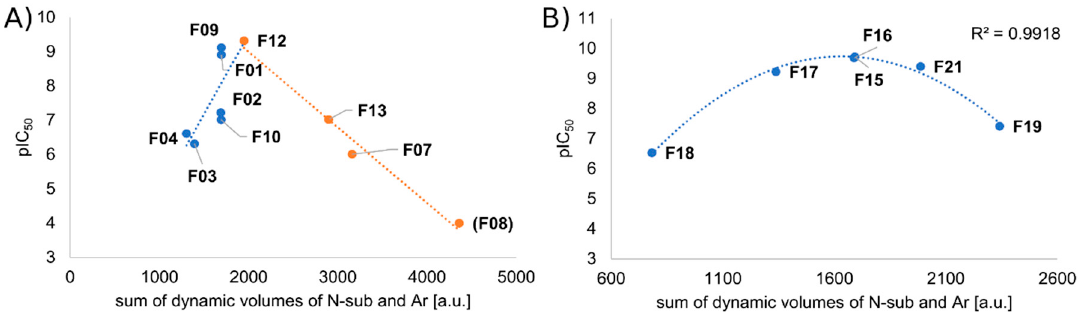
Figure 9. Plot of pIC 50 against sum of dynamic volumes of N-substituent and anilide’s aromatic: ( A ) without 4-axially substituted derivatives, ( B ) for 4-axially substituted derivatives. Volume data are collected from last 10 ns of production in 3 replicas. Chiral compounds excluded. pIC 50 value for F08 (a point in brackets) arbitrary (experimental pIC 50 < 6.0).